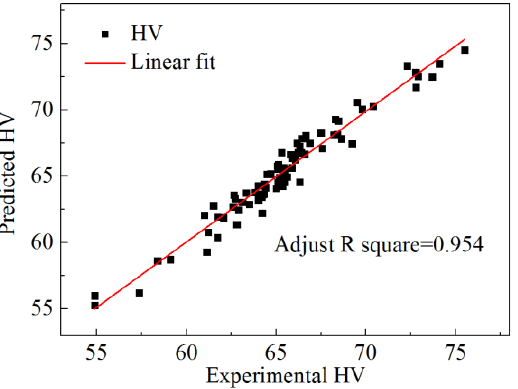
Figure 6. Analysis of the correlation coefficient between the experimental and predictive values.